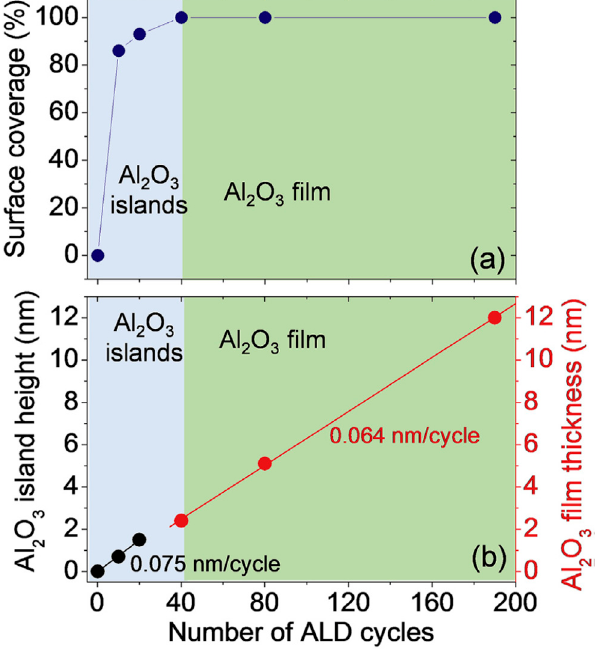
Figure 13. ( a ) Surface coverage (in %) of ALD-deposited Al 2 O 3 on epitaxial graphene/SiC versus a number of ALD cycles. ( b ) Dependences of the height of Al 2 O 3 islands (left scale) and Al 2 O 3 film thickness (right scale) on the number of ALD cycles [59]. Copyright 2020 Elsevier Ltd., Amsterdam, Netherlands.